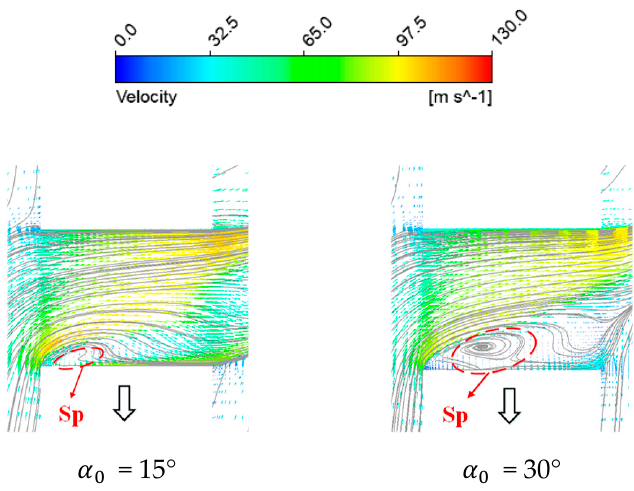
Figure 23. Streamlines of circumferential cross-section at 3000 r/min.